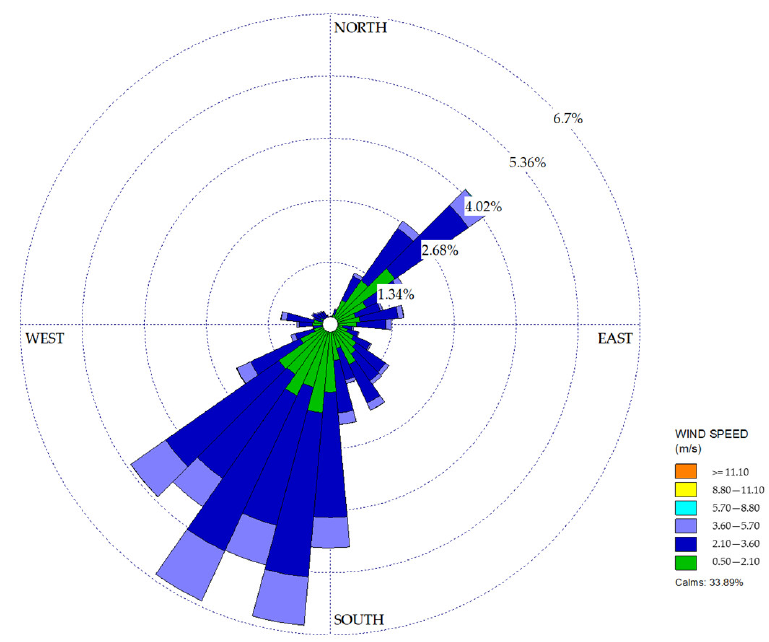
Figure 3. Wind direction from WRPLOT view.